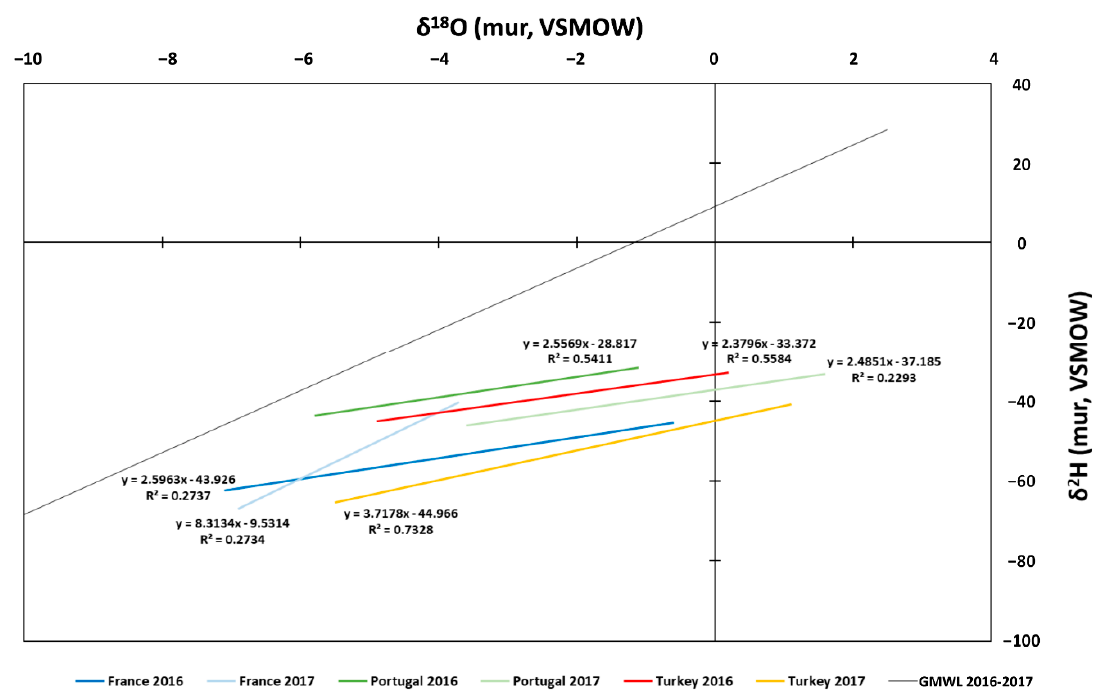
Figure 2. Local Meteoric Water Lines (LMWL) generated from the bulk δ 18 O and δ 2 H of virgin olive oil (VOO) samples. In all cases, the correlation value was highly significate ( p < 0.05). The global meteoric water line (GMWL) is shown for reference.